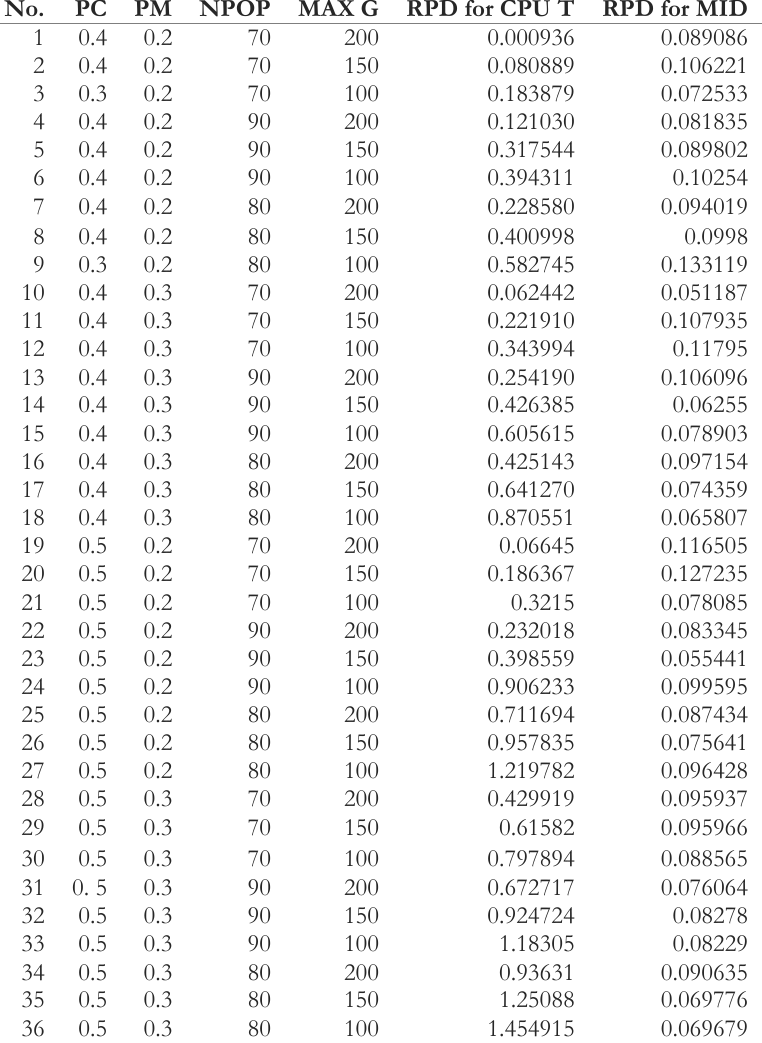
Table 11. Results of solving experiments to determine the parameters.